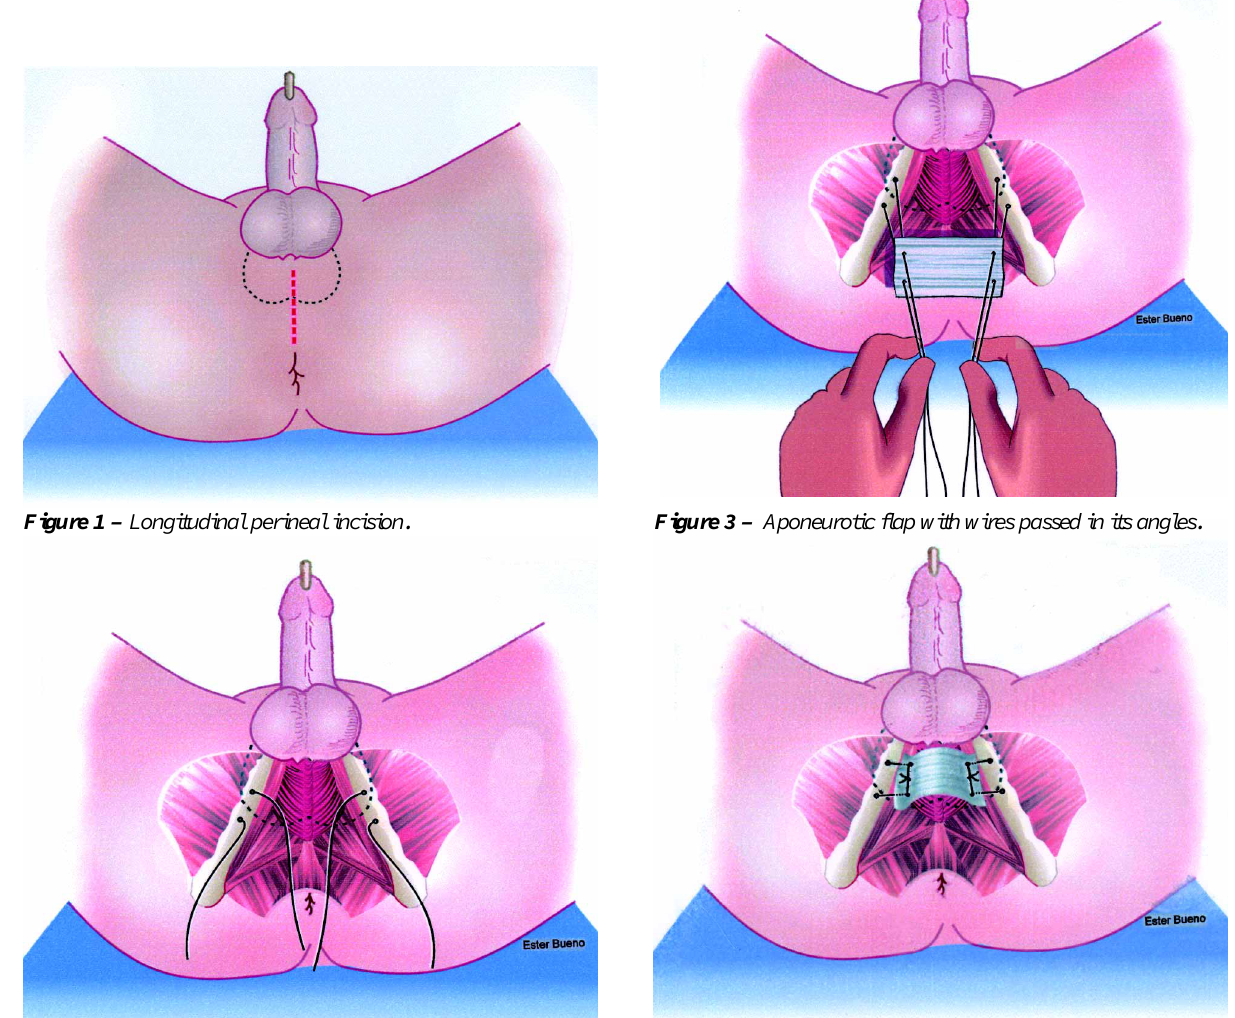
Figure 4 – Sling adjusted and placed above the bulbar